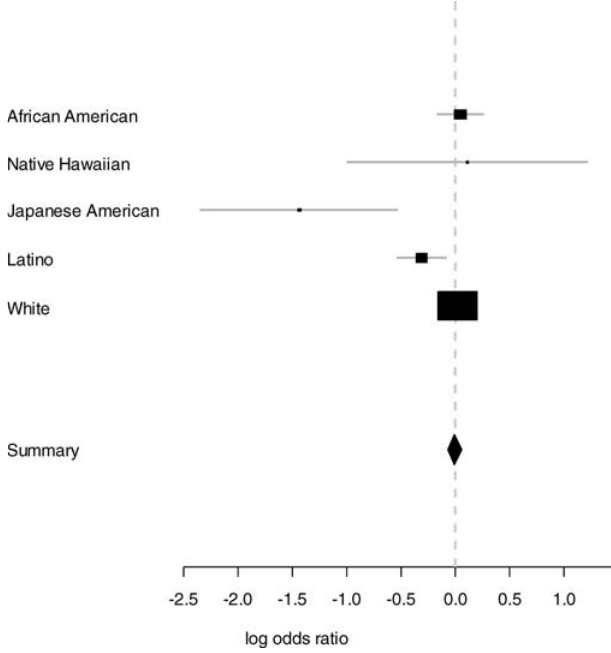
Figure 2. Plot of Log Odds Ratios for CAGC (Relative to All Other Haplotypes) under an Additive Model The boxes are proportional to the inverse of the parameter estimate variance; larger boxes denote more precise estimates. The error bars